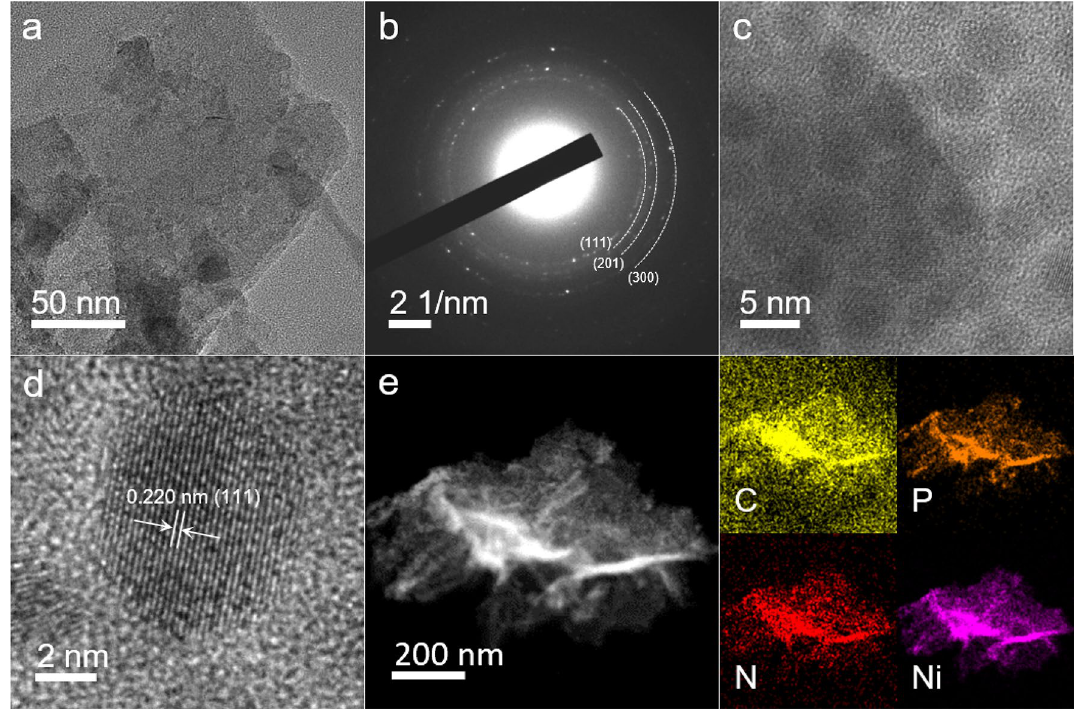
Figure 3. ( a ) TEM image, ( b ) SAED, ( c , d ) HRTEM image, and ( e ) elemental mapping image of Ni 2 P@ Ni-MOF.